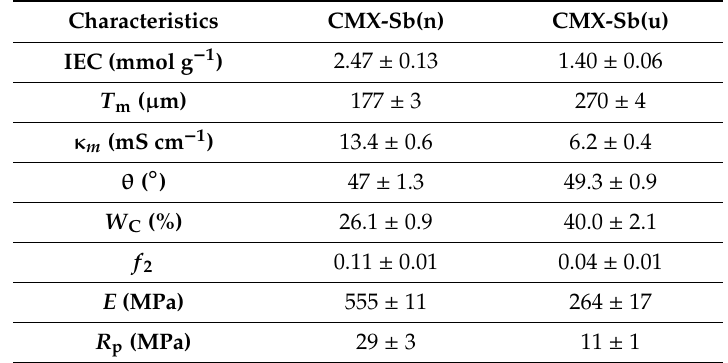
Table 1. Summary of the main characteristics of studied